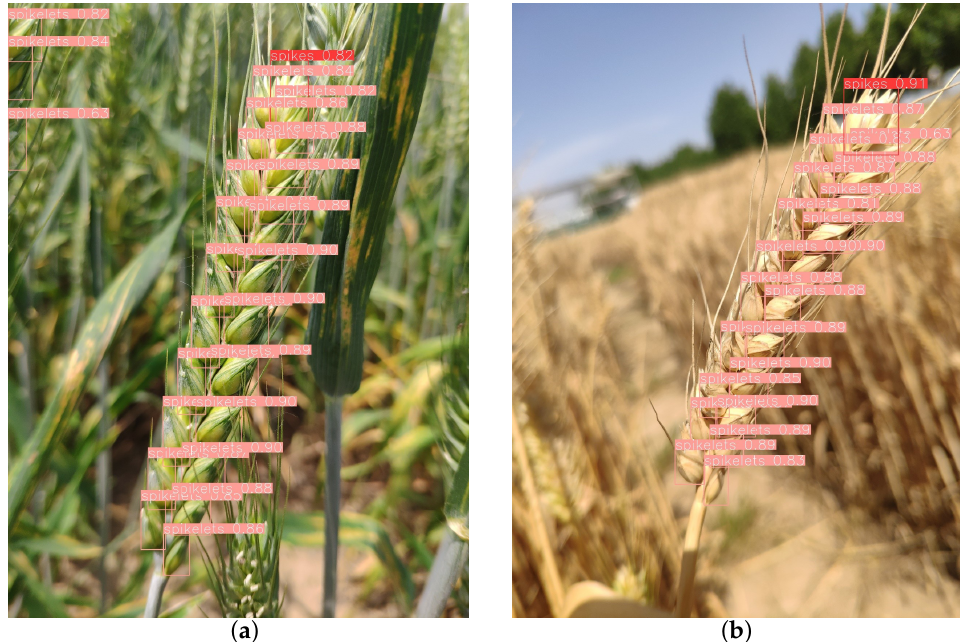
Figure 12. Example of images that affect the accuracy of spikelet counting. ( a ) Example of spikelets of background detected results, ( b ) example of spikelets in maturity